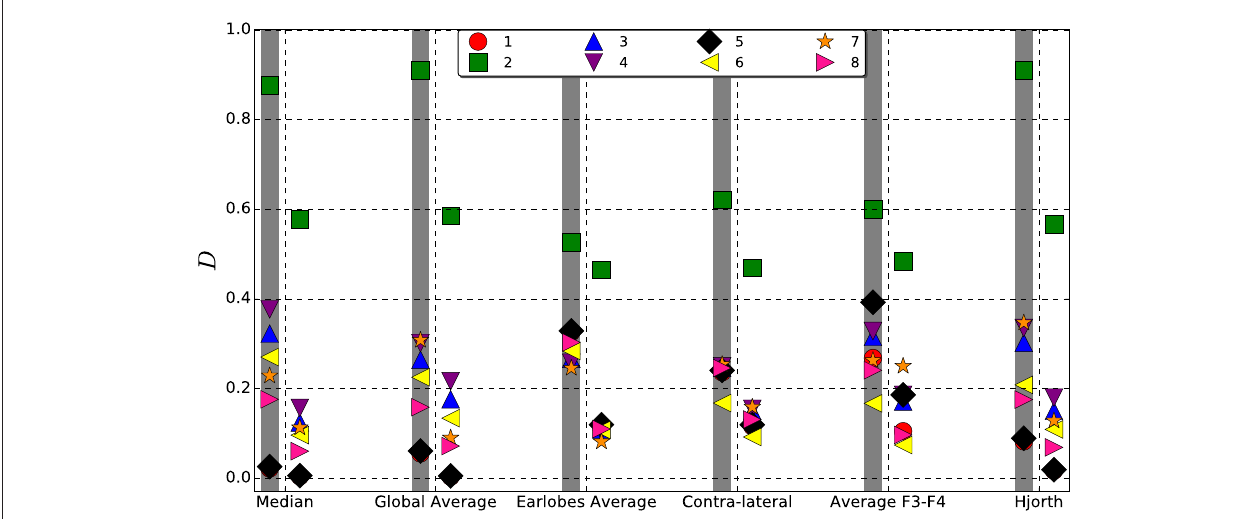
FIGURE 3 | Average deviation D (Equation 15) from the original, viz. untransformed interrelation pattern caused by different reference schemes estimated for synthetic data derived from each of the models listed in Table 1 . Left columns, indicated by a gray shadow, show the results obtained for the correlation matrix, right columns those for the mean phase coherence